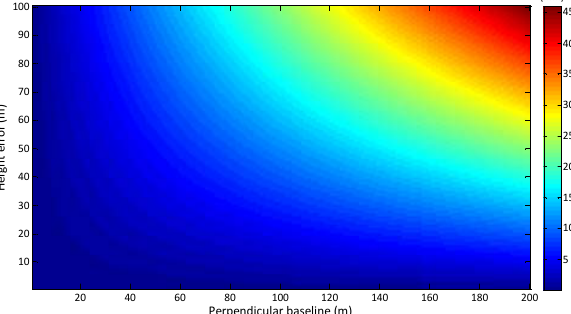
Figure 1. The LOS motion error is represented as a function of the perpendicular baseline length and the height error for the case of TSX